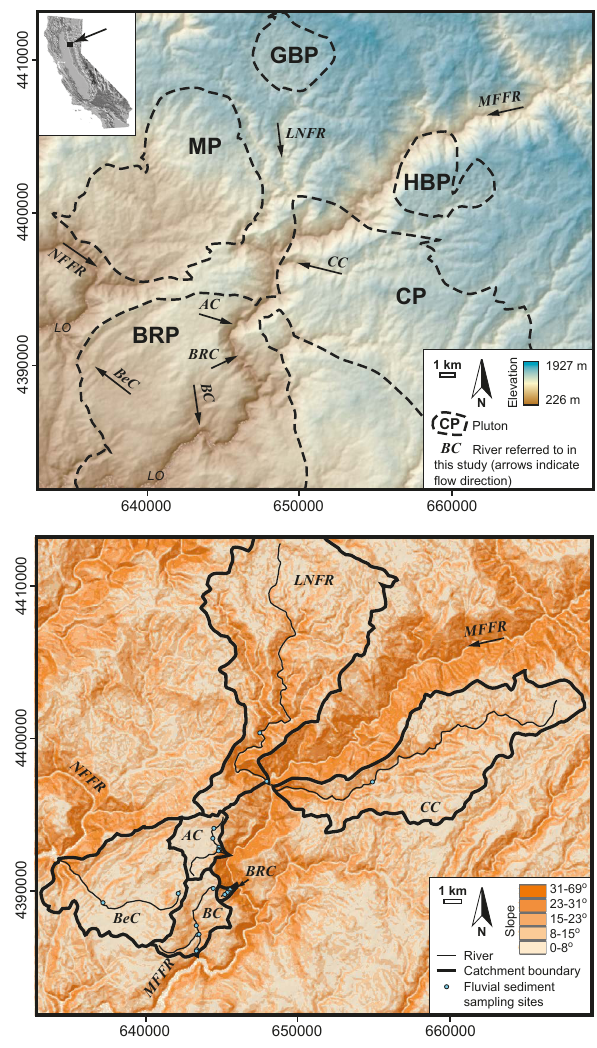
Figure 1. Overview of study area. Topographic data from USGS (National Elevation Dataset). The spatial reference system is UTM Zone 10N with units in metres. Top panel: shaded relief of the study area showing the distribution of the Mesozoic plutons (from Geo- logical map of the Chico Quadrangle; Saucedo and Wagner, 1992) and the studied rivers. Inset shows location of study area in Califor- nia. Plutons (bold): BRP – Bald Rock; CP – Cascade; GBP – Gran- ite Basin; HBP – Hartman Bar; MP – Merrimac. Rivers (bold italic): AC – Adams Creek BC – Bean Creek; BeC – Berry Creek; BRC – Bald Rock Creek; CC– Cascade Creek; LNFR – Little North Fork River; MFFR – Middle Fork Feather River; NFFR – North Fork Feather River. LO – Lake Oroville. Bottom panel: slope map of the study area draped on shaded relief, showing boundaries of studied basins and sampling sites.